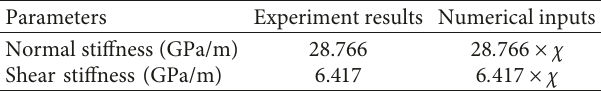
Figure 5: Information for a smooth joint (modified from [28]) in (a) continuous material, (b) regularly generated discrete material, and (c) randomly generated discrete material. Table 3: Experimental and numerical stiffnesses of the